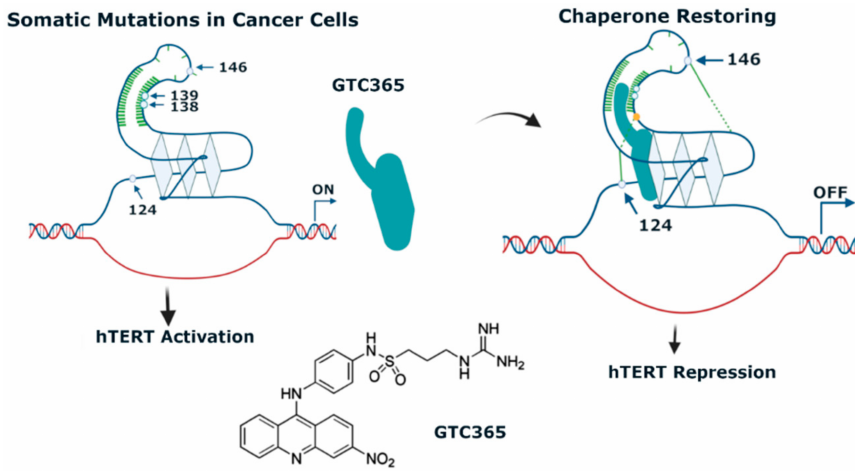
Figure 5. Mechanism of hTERT regulation by GTC365 . Human telomerase reverse transcriptase (hTERT) is transcriptionally silenced in normal cells. Mutations in hTERT promoter have been found to occur in many cancer types, which activate hTERT transcription. The acridine GTC365 partially restores the wild-type G4-folding leading to hTERT transcription repression. Table 1. Effects of selected G4 ligands in in-vitro and in-vivo cancer models. Structures are depicted in Figure